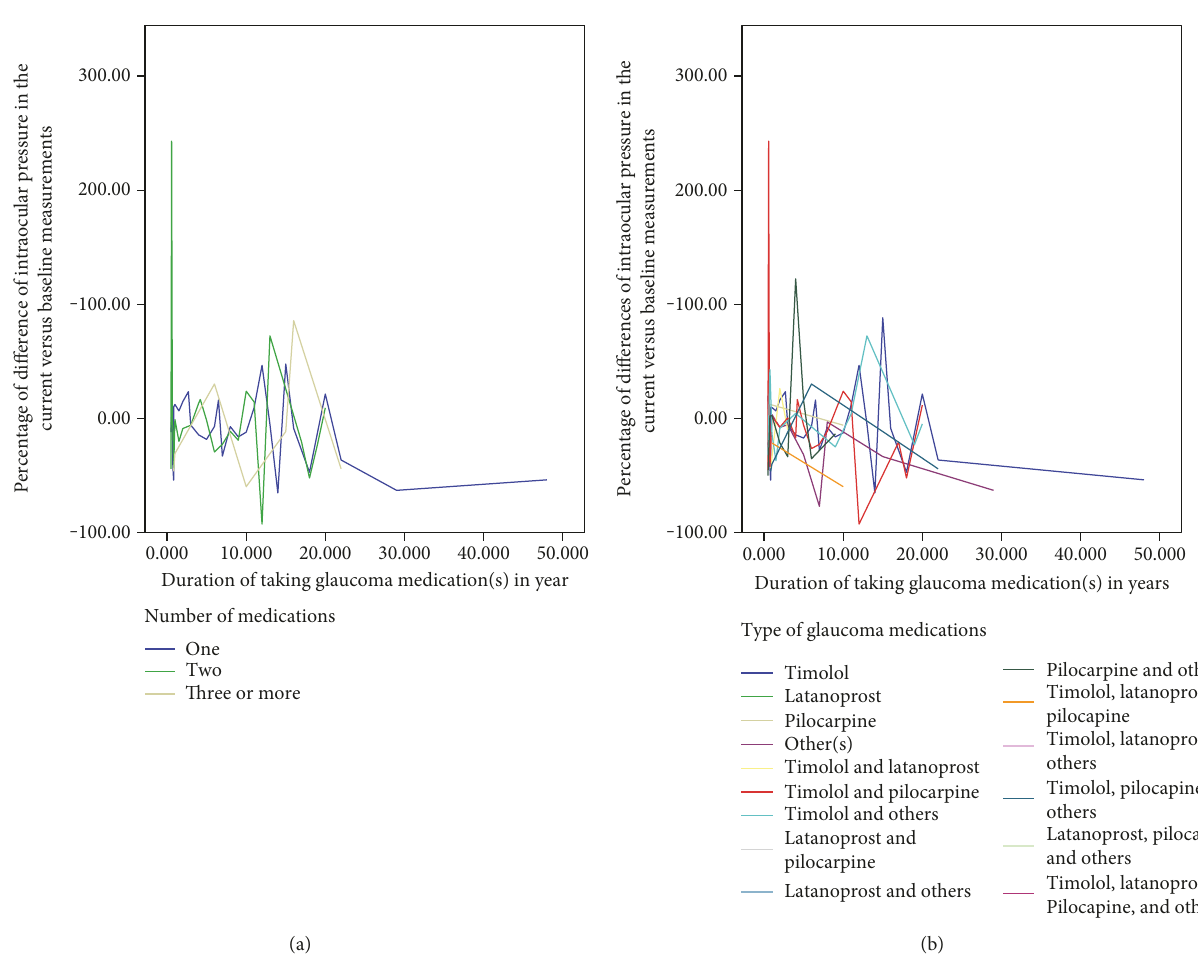
Figure 5: Relationship of intraocular pressure with the type and number of medications among glaucoma patients in Menelik II Hospital, 2015. (a) By the number of medications; and (b) by the type of medications. Table 1: Association of medication adherence with instillation pro fi ciency among patients attending the glaucoma clinic of Menelik II Hospital, 2015.